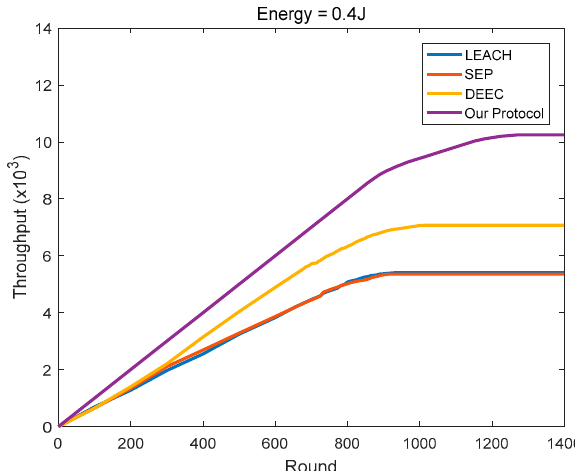
Figure 20. The network throughput varies with the round (initial energy = 0.4 J).